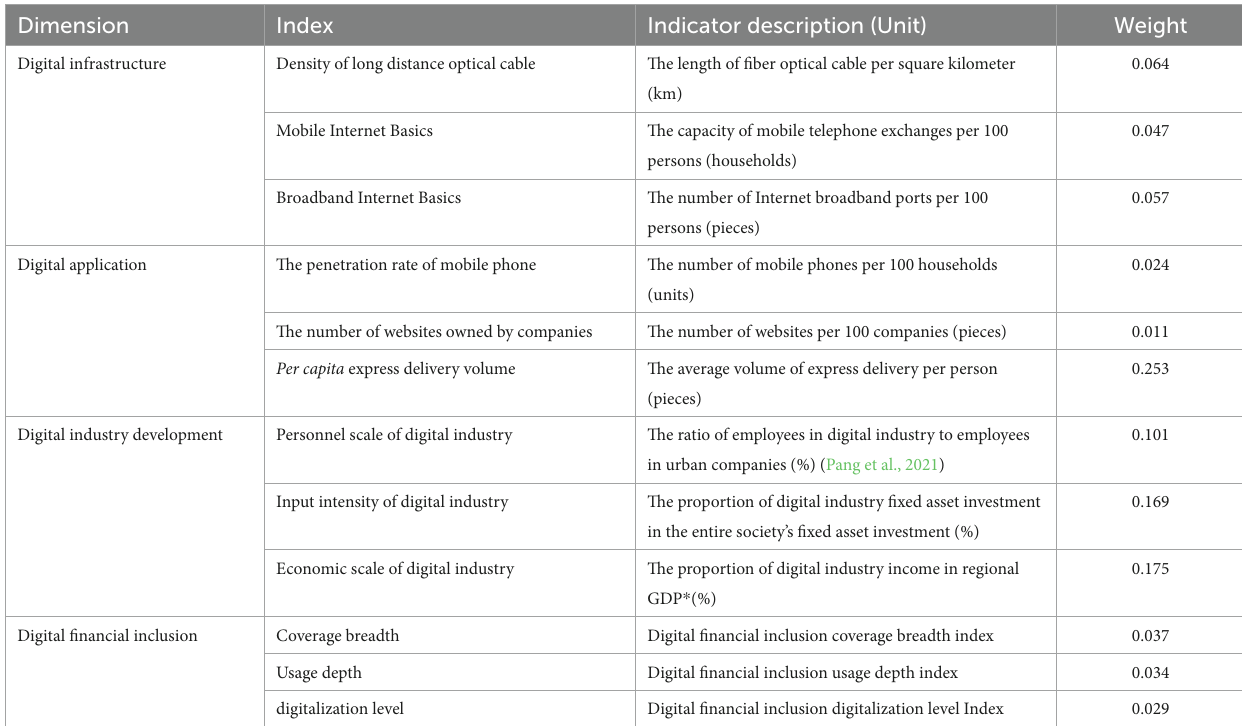
TABLE 1 Index system of urban